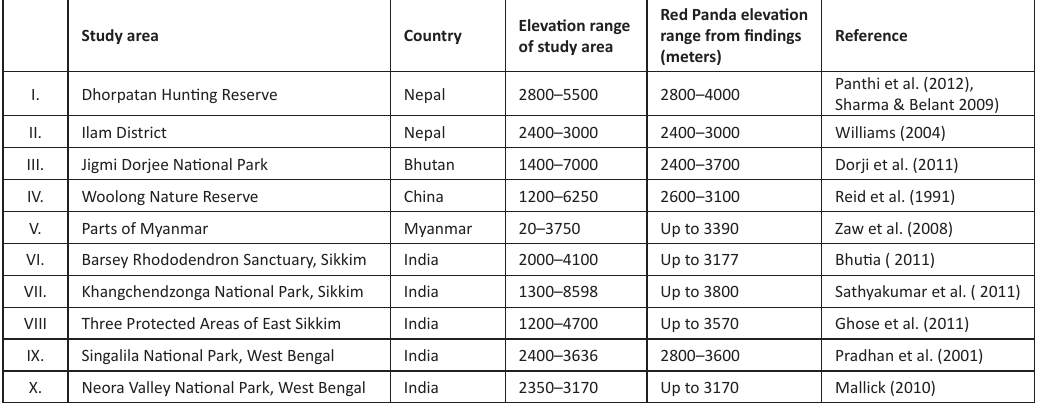
Table 1. Compilation of recent published studies showing altitudinal distribution of Red Pandas in the range